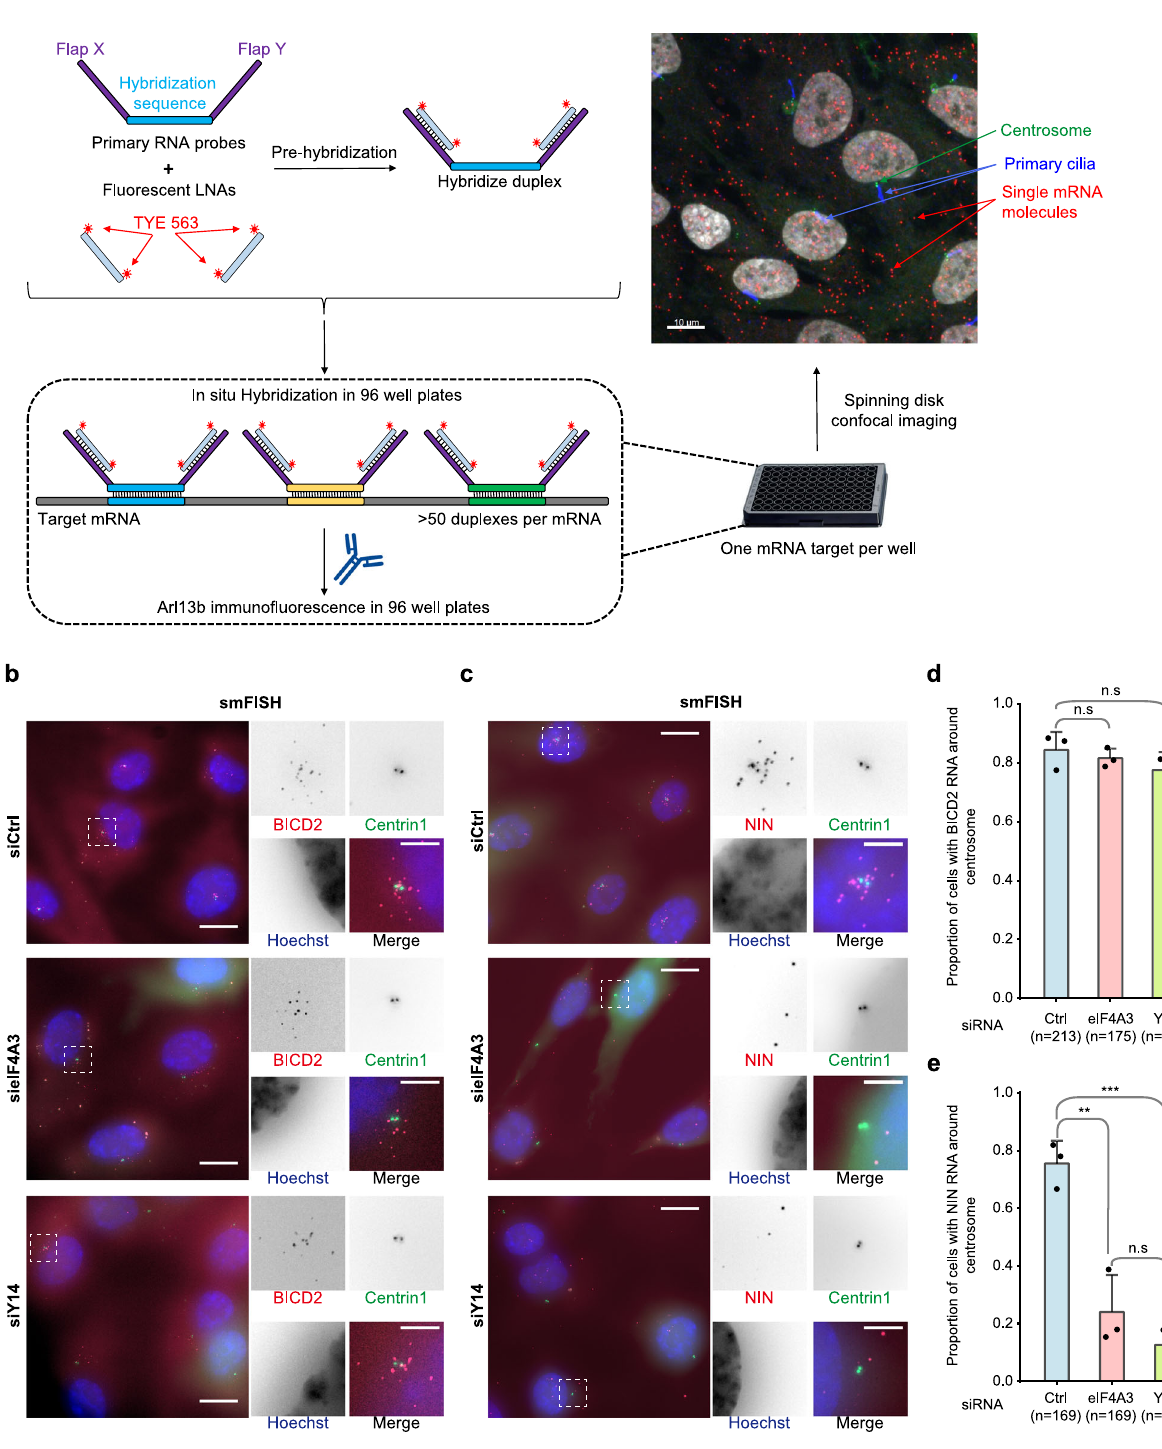
CAUUCGCUCAGCUCAUAAU-3 ′ ) with Lipo2000 (Invitrogen) in Opti-MEM (Gibco). After 3h, cells are replaced in DMEM with FBS and processed on day 4. If required, cells were serum-starved on day 2. Antibodies . Provider, clone number, catalog number, lot number, host, and dilution folds are depicted in brackets as applicable. For Western blot and RIP: α - Puromycin (Merck, 12D10, MABE343, 2923223, mouse, 1:12,500), α -GAPDH (cell signaling, 14C10, 2118S, 14, Rabbit, 1:5000), α -eIF4A3 (af fi nity puri fi ed from